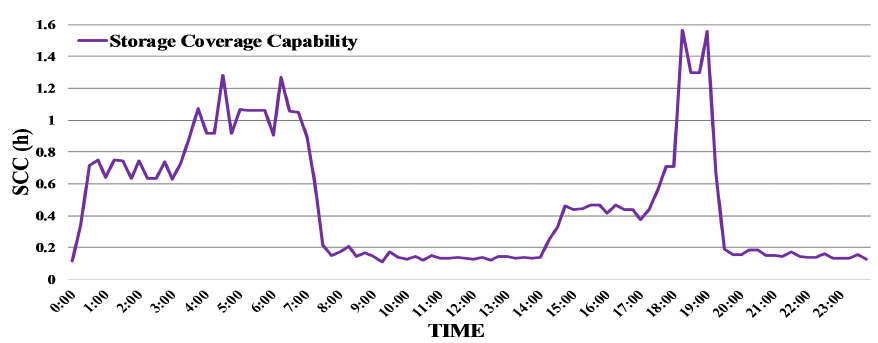
Figure 6. Storage Coverage Capability on the 23 August 2019.